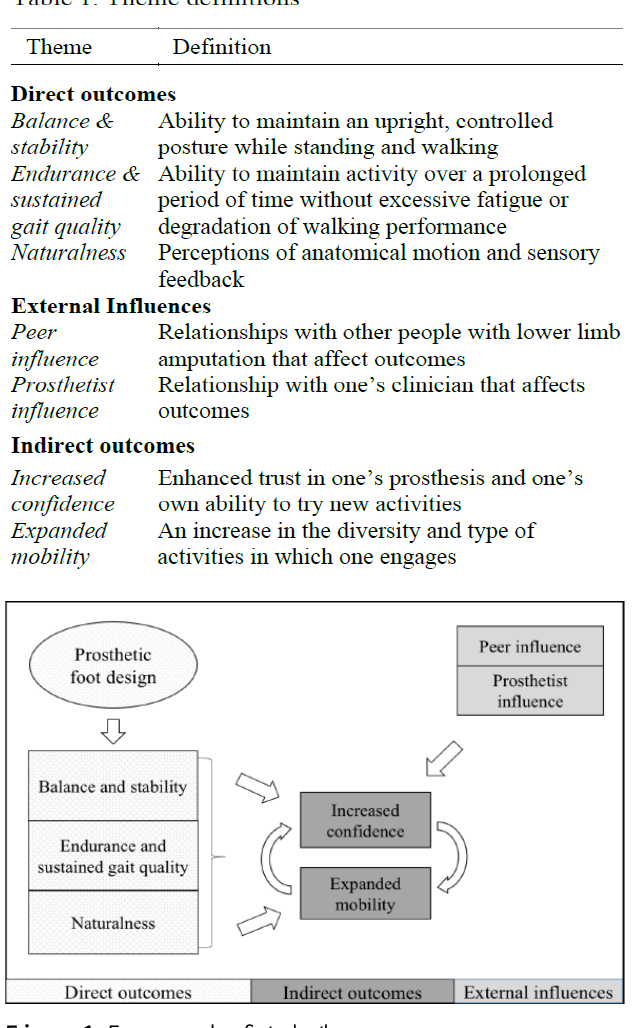
Figure 1. Framework of study